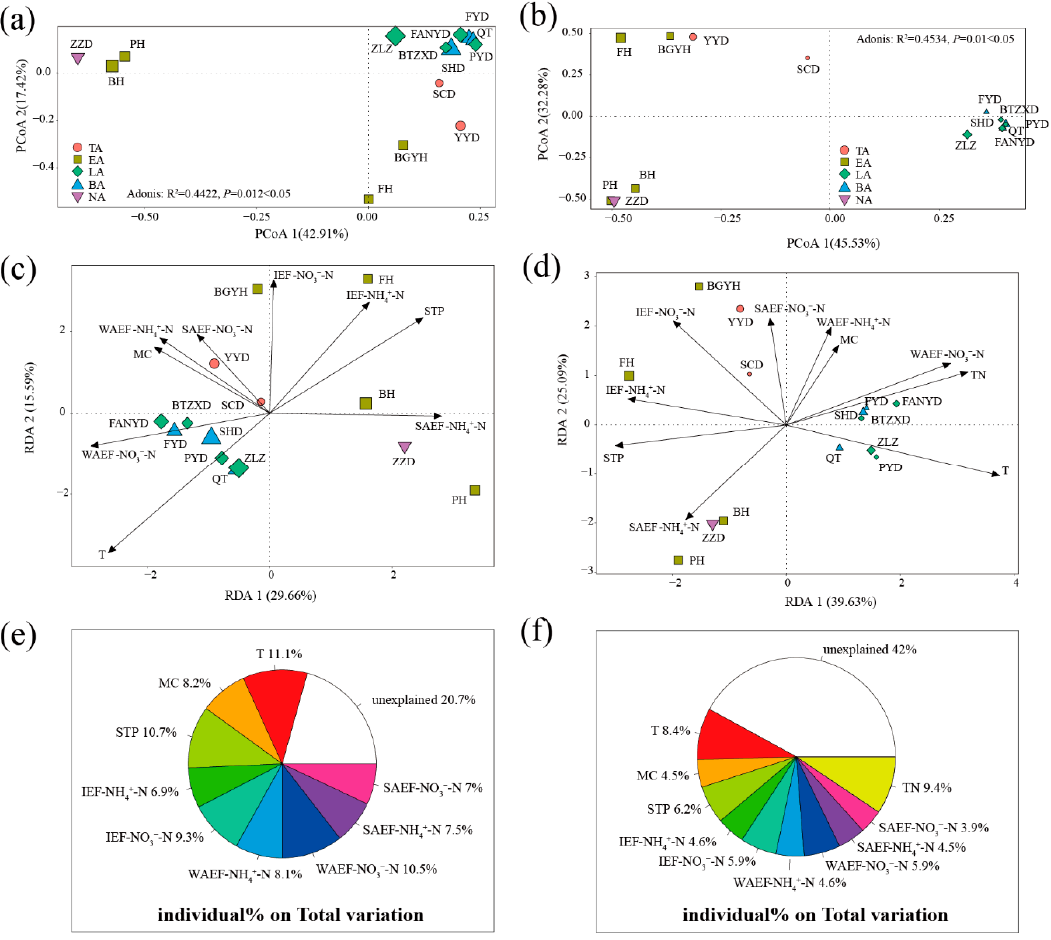
Figure 5. PCoA, RDA, and HP of whole and keystone aerobic denitrifying microbial community in Baiyangdian Lake. ( a , b ), PCA of whole and keystone aerobic denitrifying microbial community; ( c , d ), RDA of whole and keystone aerobic denitrifying microbial community; ( e , f ), HP of whole and keystone aerobic denitrifying microbial community.